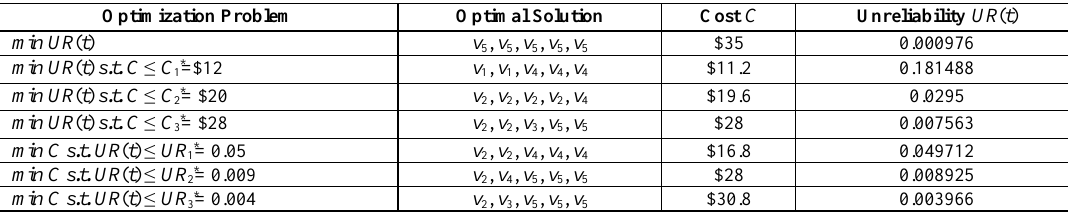
Table 5. Optimal results of 4-out-of-5 with 5 disk